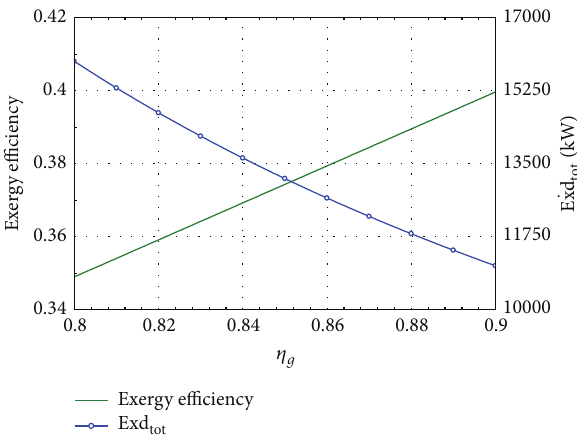
Figure 7: Variation with gas turbine isentropic efficiency of exergy efficiency and total exergy destruction